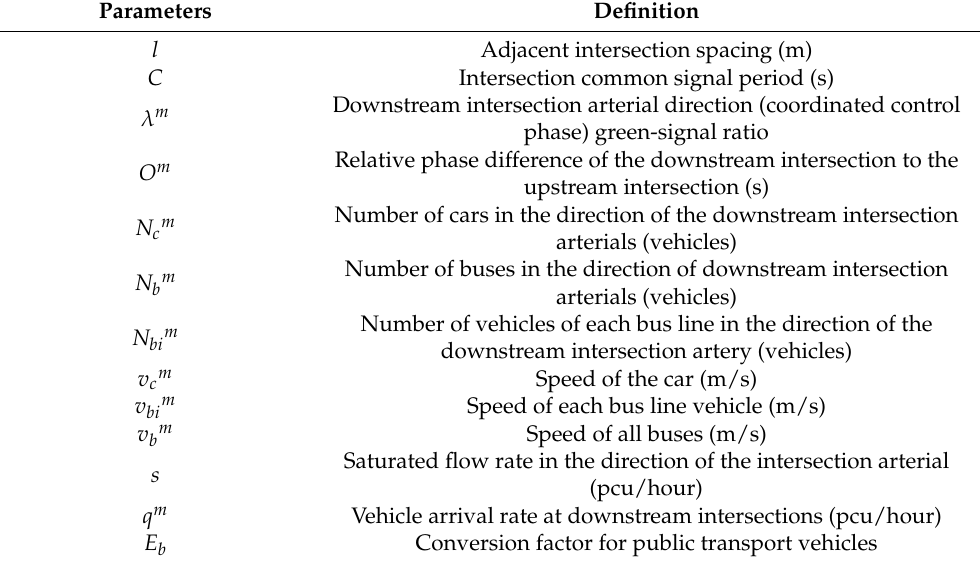
Table 1. Parameter